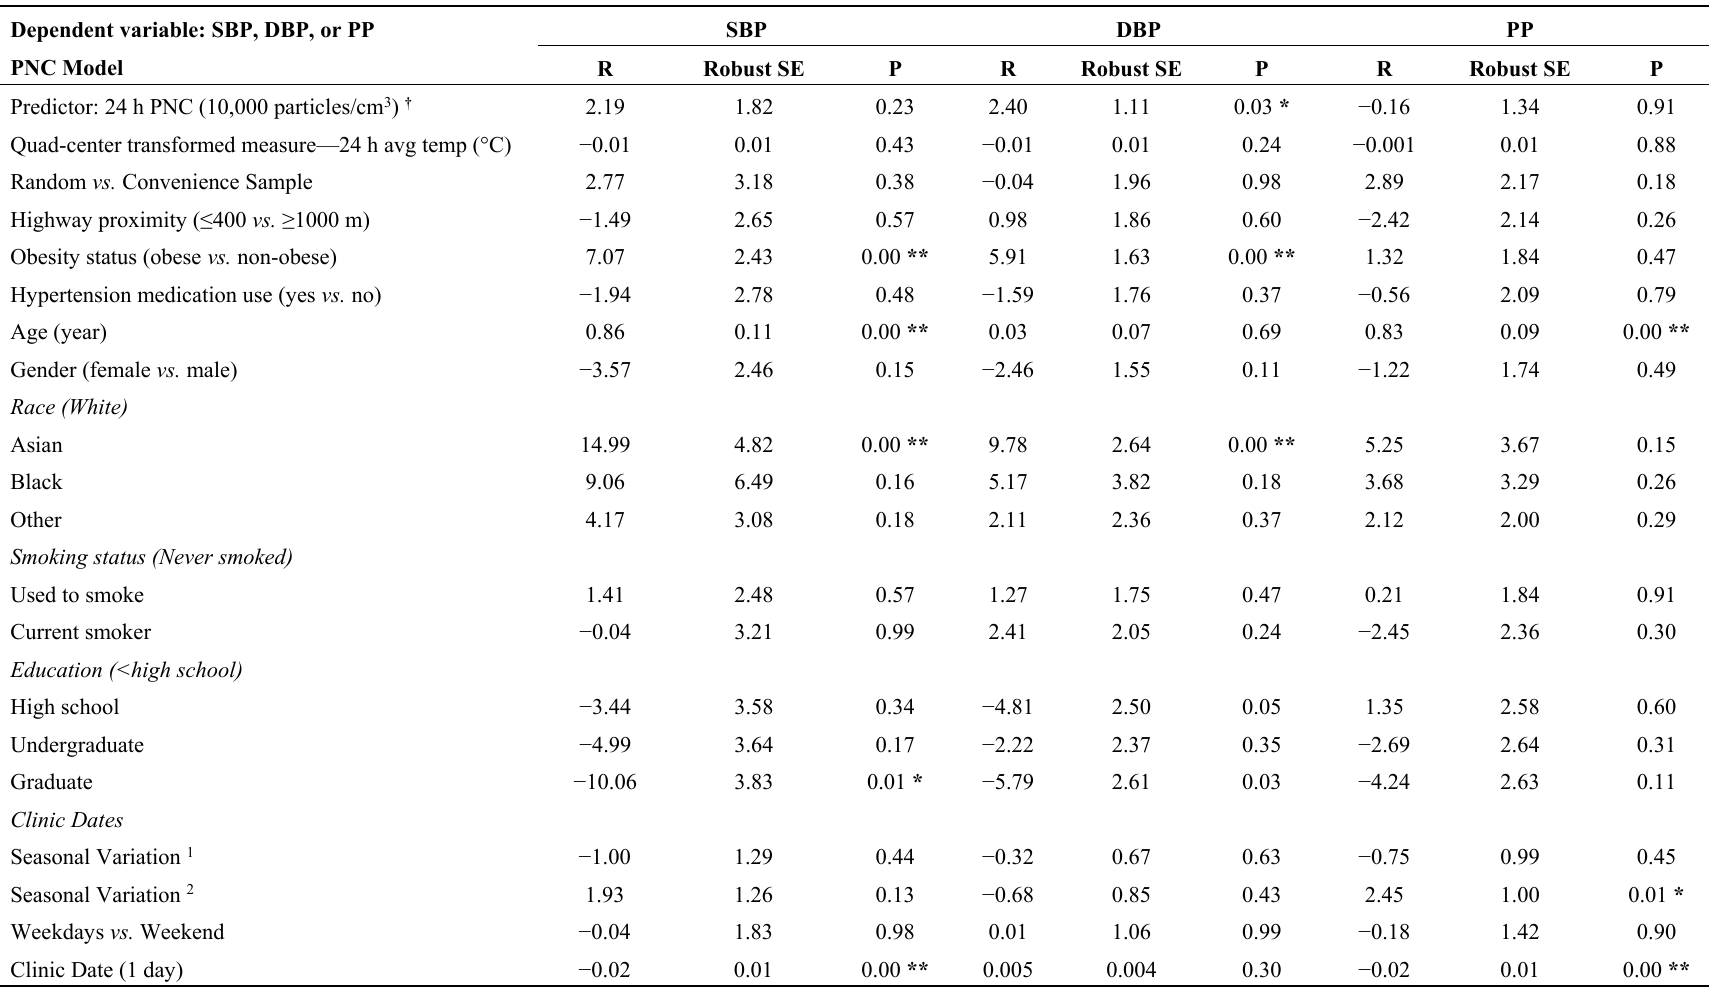
Table 4. Linear Mixed Model of PNC (number of observations = 302 in 190